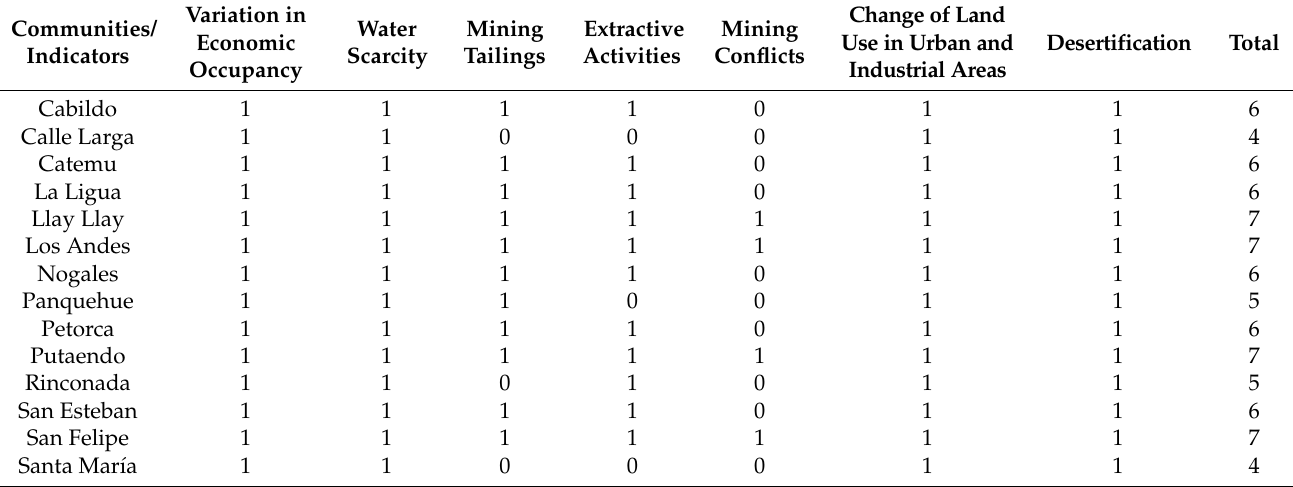
Table 4. Matrix of propensity for rural